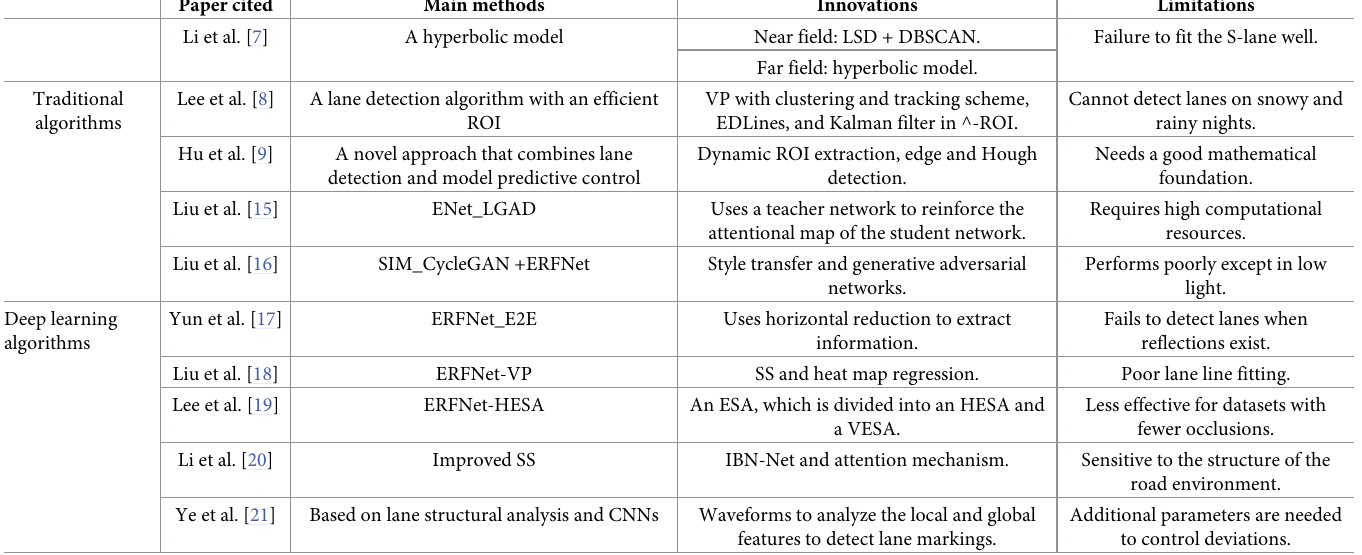
Table 1. Summary of the related